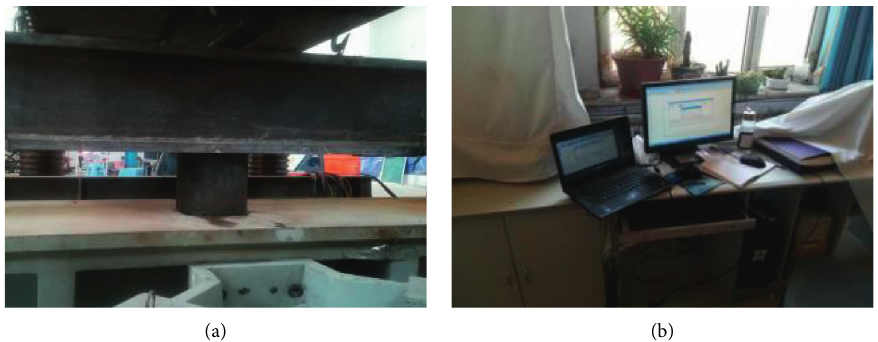
Figure 3: Unconfined compressive strength test of a CSMB